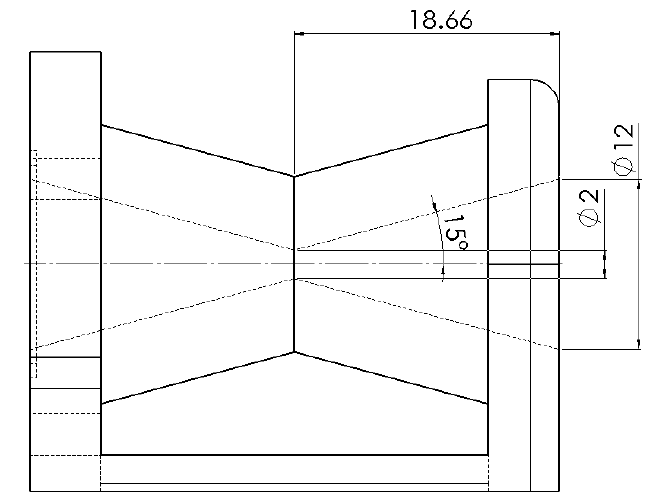
Figure 3. Mechanical drawing showing side view of the thruster design geometry. Dimensions are in mm.